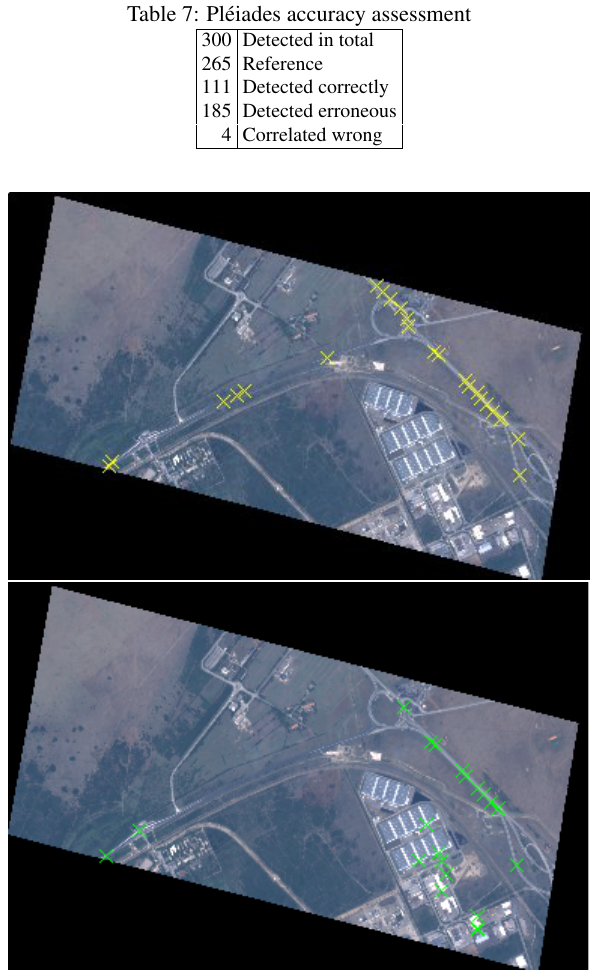
Figure 25: Example SkyBox image, 3 × 2 km 2 near Fos-sur- Mer in southern France, top: reference of manually measured cars (yellow crosses), bottom: automatically found moving ob- jects (green crosses) by all manually measured cars. The false-detect-rate is the num- ber of objects detected automatically but not manually verified divided by all automatically detected objects. The miscorrelation rate is the number of wrongly correlated objects divided by the number of all correctly detected objects (so the object was found correctly in one band, but the wrong mate in the other band was taken for the speed calculation). Table 8: Quality measures for the assessed